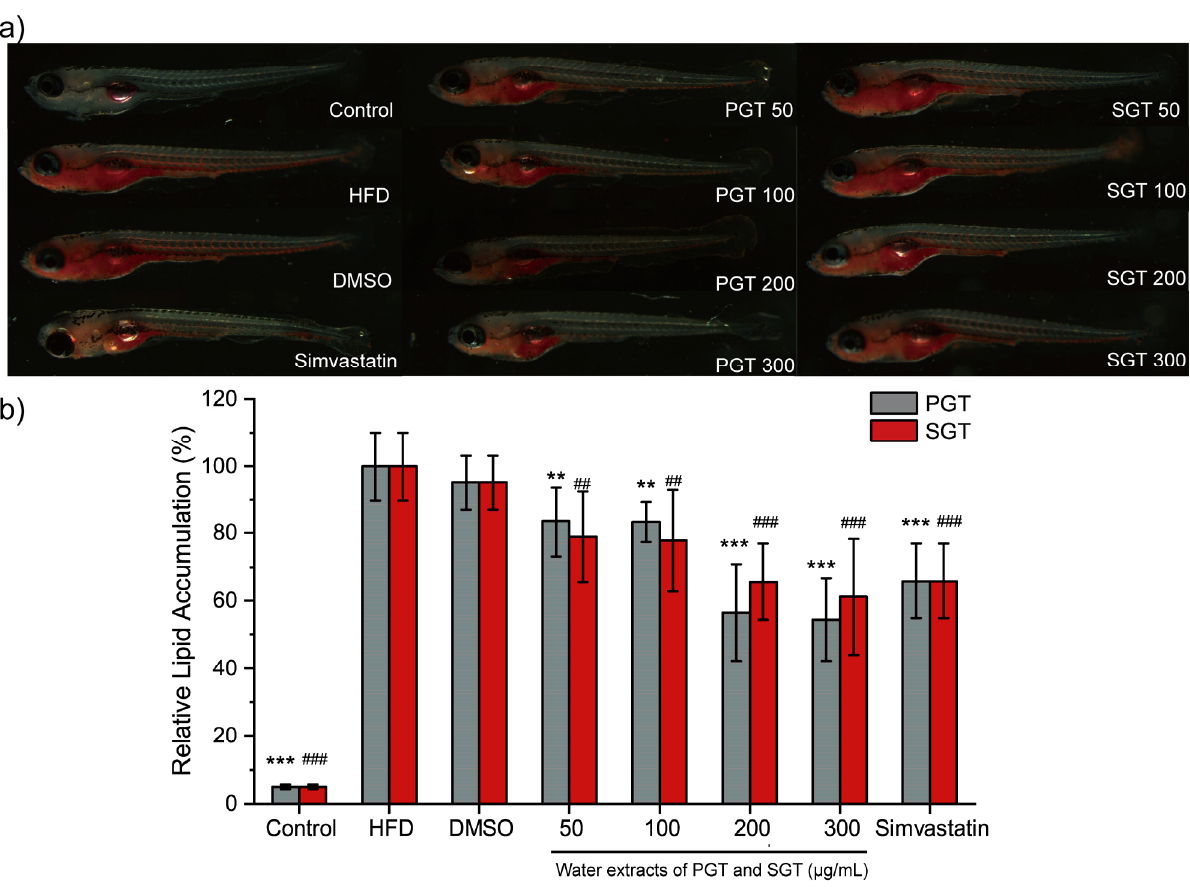
Figure 6. Assessment of lipid-lowering effects of PGT and SGT in a high-fat zebrafish larvae model. ( a ) Zebrafish larvae stained with oil red O and visualized under a microscope; ( b ) Relative lipid accumulation quantified with Image-pro plus software. PGT, pan-fired green tea; SGT, steamed green tea; HFD, high-fat diet. The two column charts of PGT and SGT in control, HFD, DMSO and simvastatin groups were produced based on the same data of each group. ‘*’ represents the significant difference between PGT group and HFD group; ** p < 0.01; *** p < 0.001; # represents the significant difference between SGT group and HFD group; ## p < 0.01; ### p < 0.001.